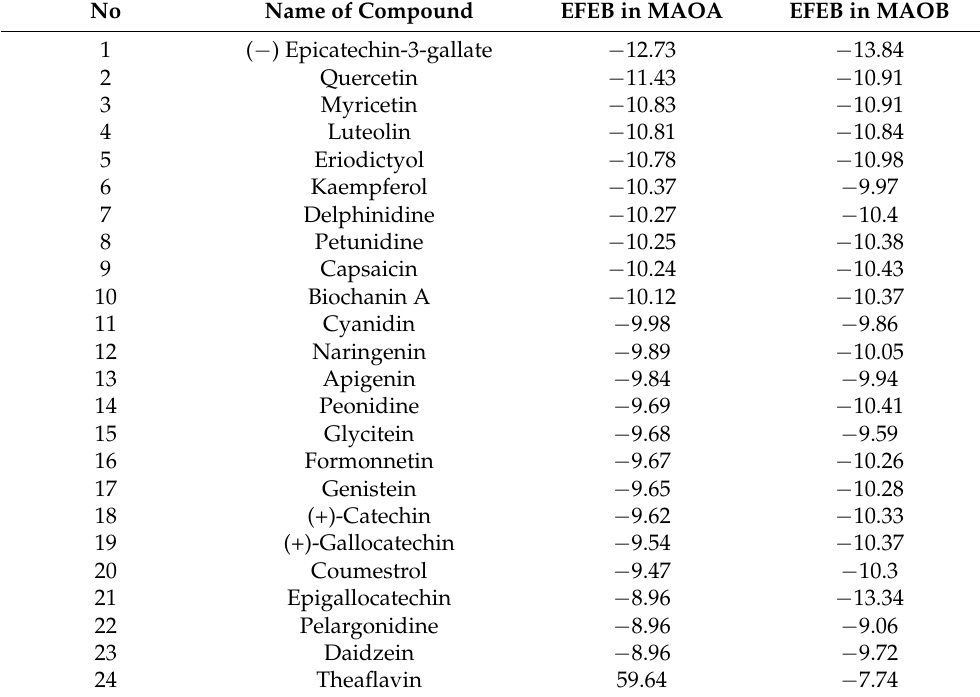
Table 6. Docking score (EFEB) of selected molecules with MAOA and MAOB.